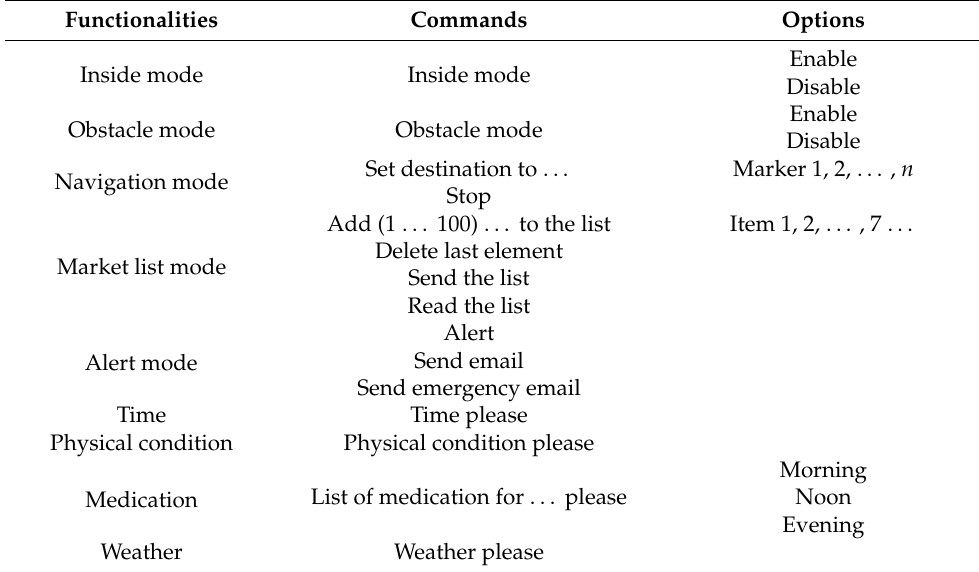
Table 2. Smart assistant functionalities, commands to activate/deactivate and options. Functionalities